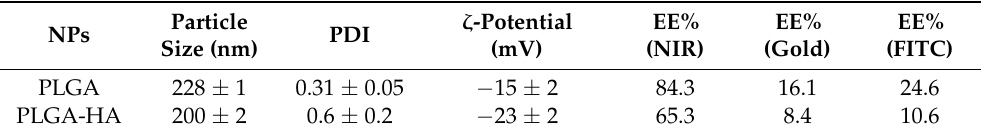
Table 1. NPs size, PDI, ζ -potential, and NIR dye, gold, and FITC dye drug encapsulation efficiency (EE) of PLGA NPs and PLGA-HA